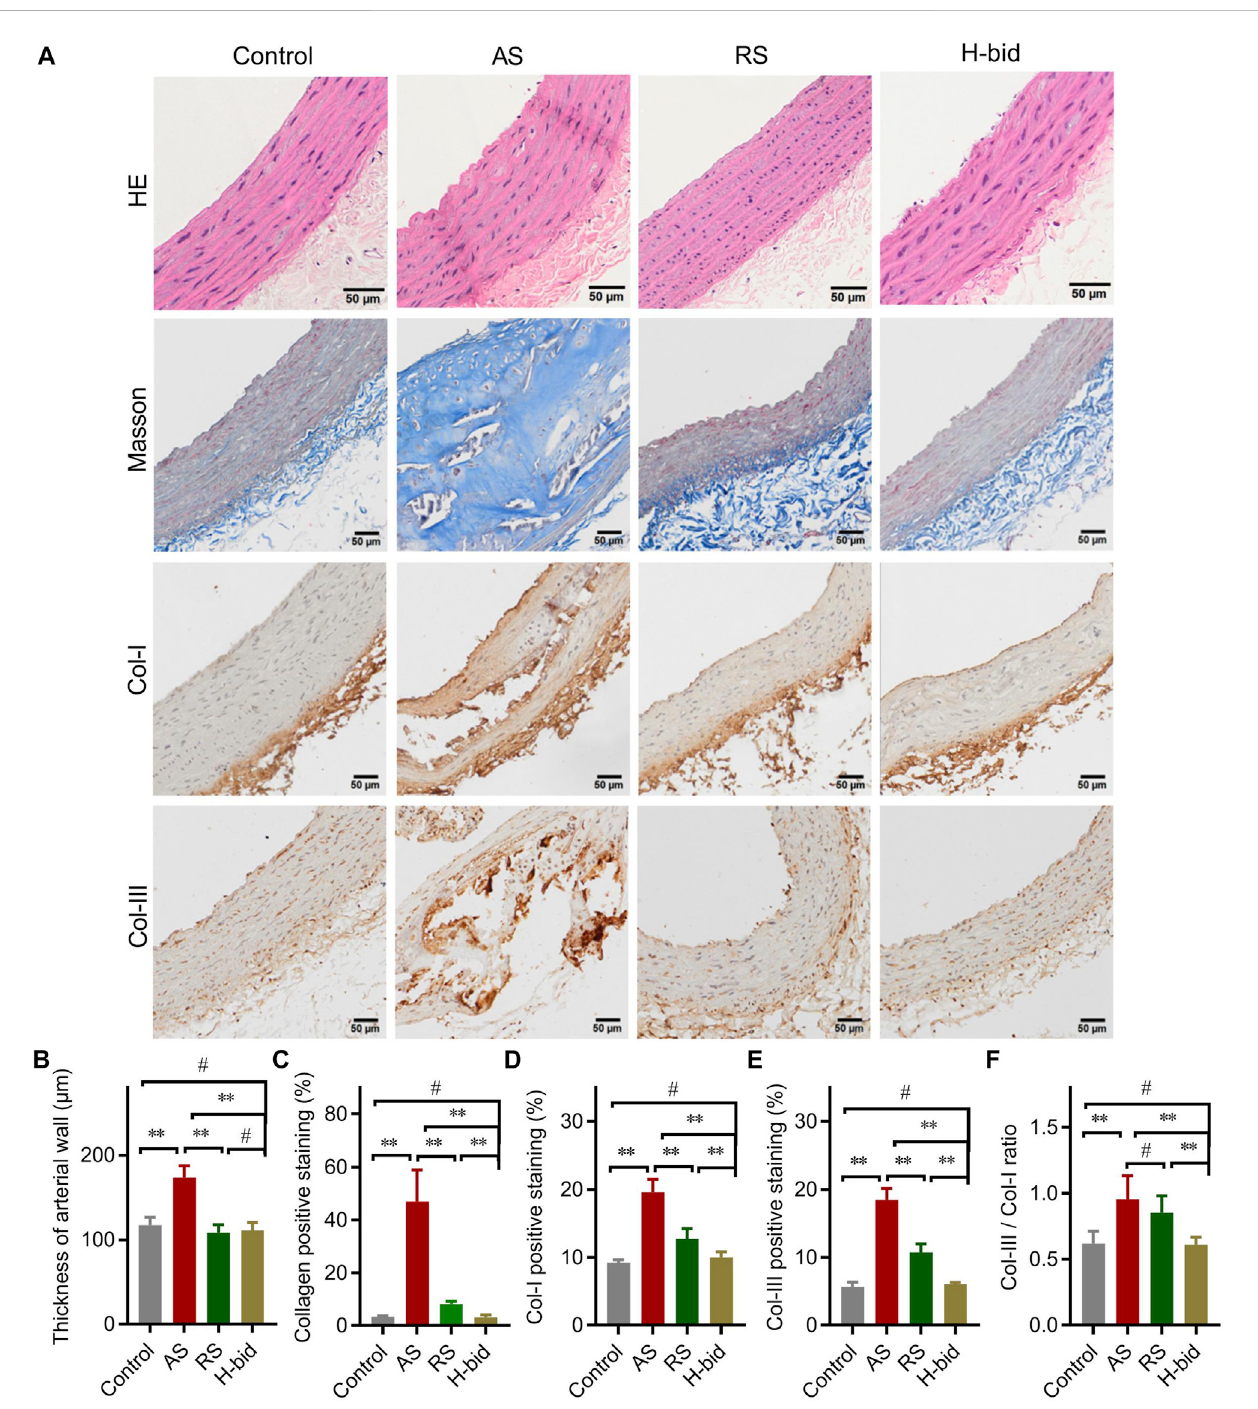
FIGURE 2 Art attenuates arterial remodeling in AS rats. (A) HE staining, Masson ’ s staining, and IHC staining of arterial sections. Paraf fi n sections were stained using HE, Masson ’ s trichrome, or were probed by antibodies against Col-I and Col-III using the IHC method and observed under a light microscope (Bar = 50 μ m). (B) Thickness of the arterial wall. (C) Collagen-positive staining (%). (D) Col-I-positive staining (%). (E) Col-III-positive staining (%). (F) Col-III/Col-I ratio. n = 5; ** p < 0.01; # p >